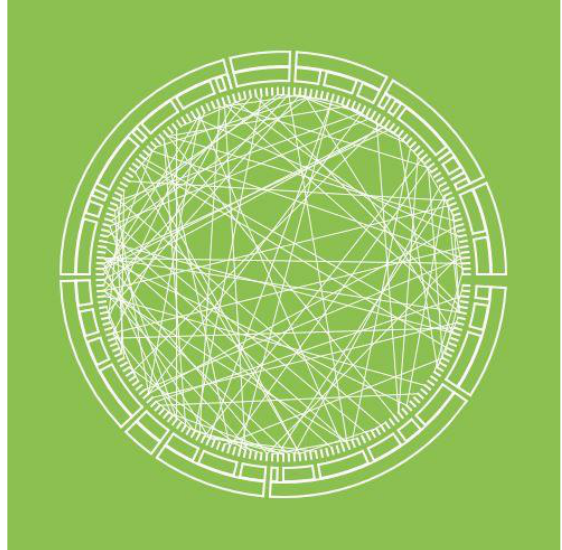
Figure 11. Chord diagram with straight edges. The outer shell consists of three rings, displaying a hierarchical topology. The inner shell consists of an unconnected graph.